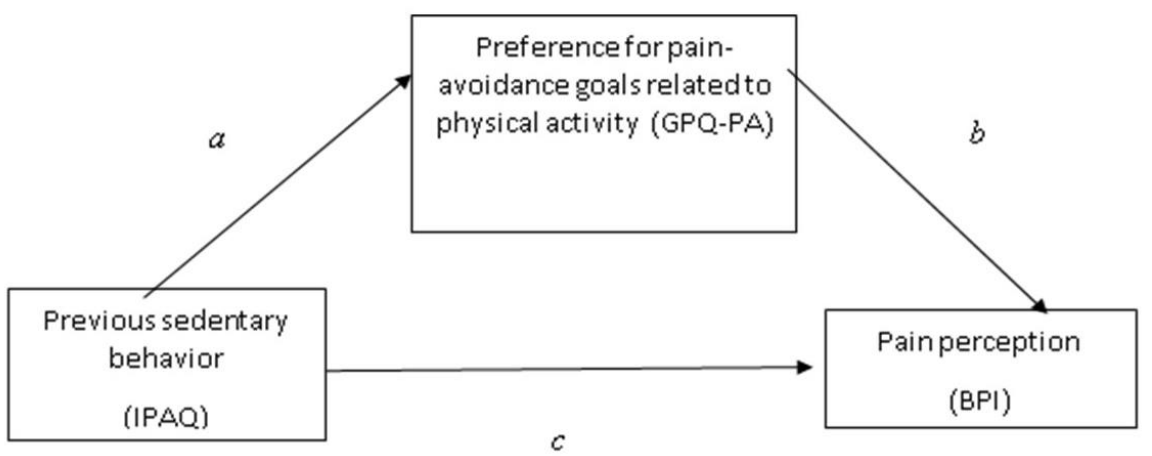
Figure 1. A conceptual and statistical diagram of a simple mediation model. To explore the moderating effects of pain catastrophizing, on the relationship between sedentary behavior, preference for pain-avoidance goals (in relation to physical activity), and pain severity after the 6MWT (H2), considering the aforementioned covariates, we proposed a moderated-mediation model with model 14 (see Figure 2). The number of bootstrap samples was 10,000 and all confidence intervals were 95%.